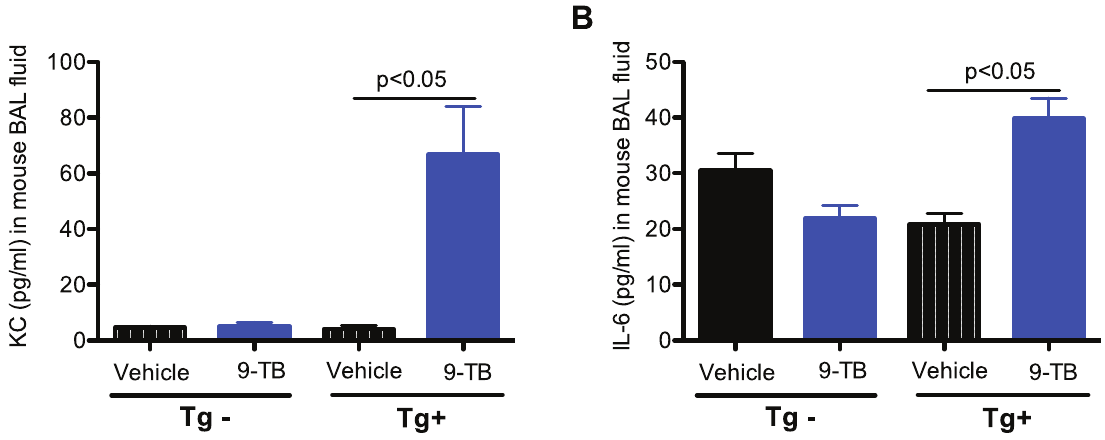
Figure 4. 9-TB treatment increases KC and IL-6 levels in CC10- CA IKK b transgene positive (Tg + ), but not transgene negative (Tg–) mice with saline treatment. ( A ) – KC; ( B ) – IL-6. N=4–6 mice per group. Data are expressed as means 6